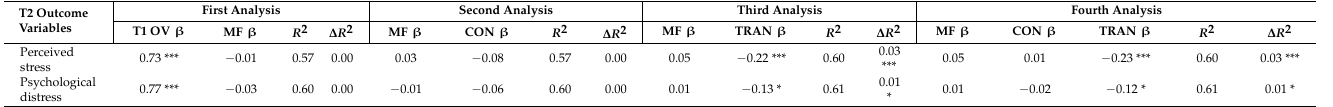
Table 4. Longitudinal effect of mindfulness, concentration and tranquility on outcome variables: results of longitudinal hierarchical multiple regression analyses (n =